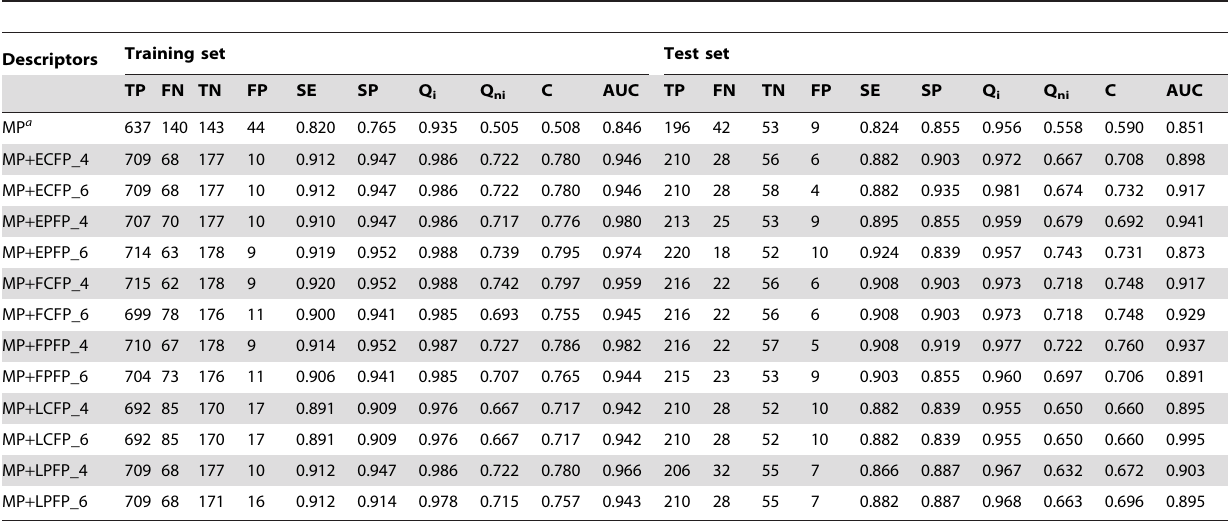
a MP represents thirteen molecular properties. The best tree depth is 8 for RP models (MP, MP + EPFP_4 and MP + LPFP_6), 10 for RP models (MP + ECFP_6 and MP + LPFP_4), 11 for RP models (MP + FCFP_4, MP + FCFP_6, MP + LCFP_4, MP + LCFP_6 and MP + FPFP_6) and 12 for RP model (MP + FPFP_4). The detailed results can be found in Table S1 and Table S2 in Supporting Information.